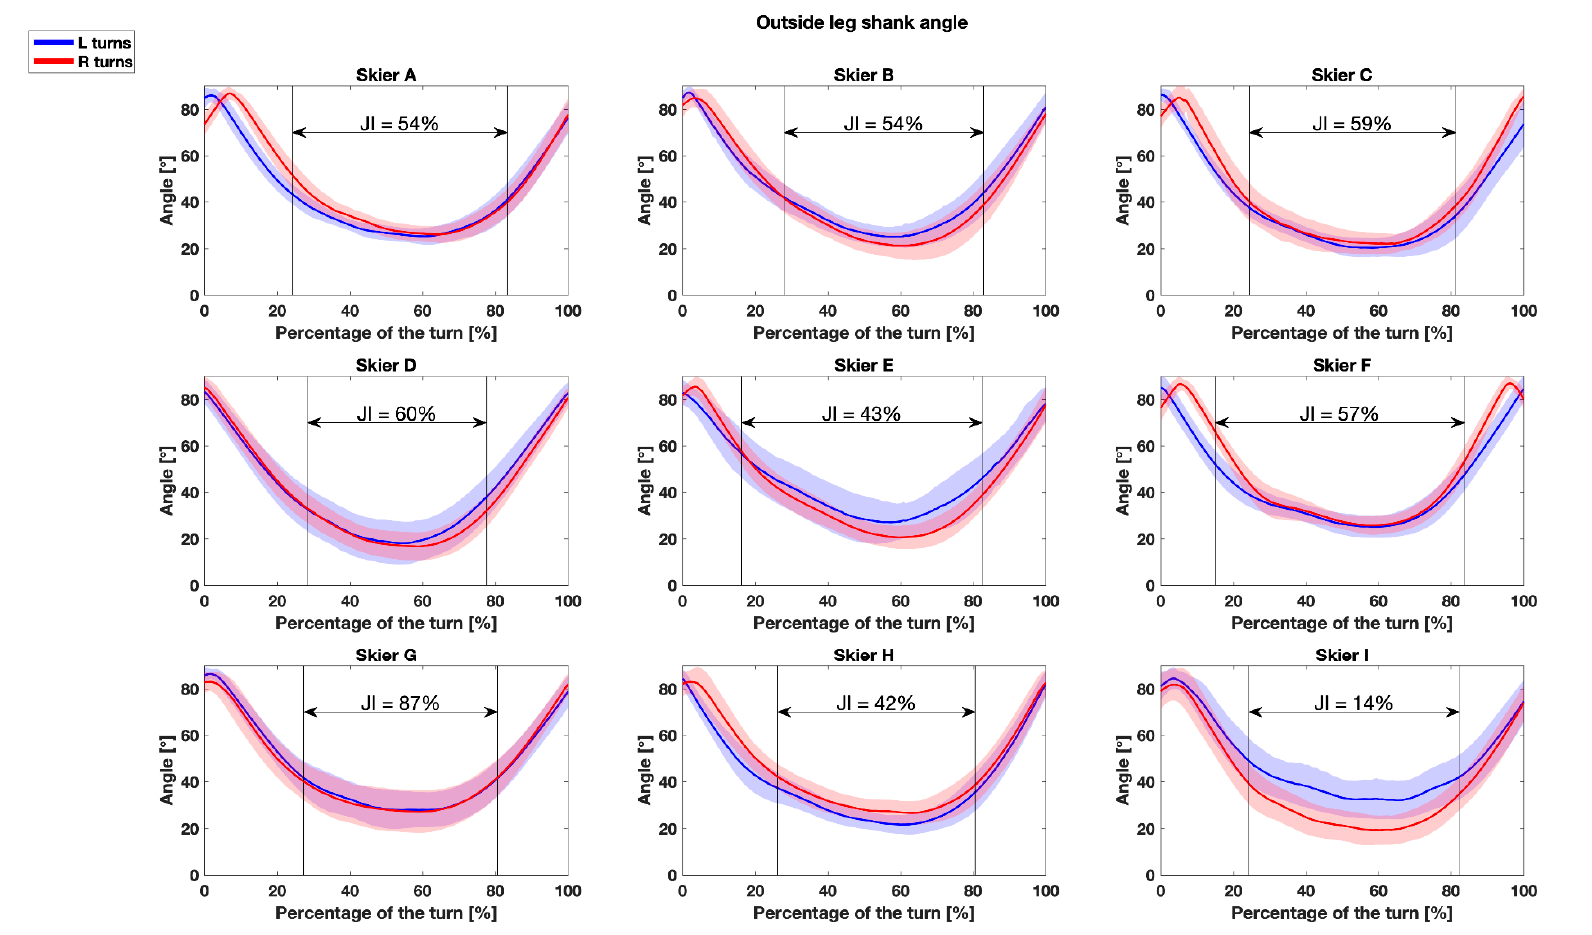
Figure 4. The angle of the outside shank of the 9 elite slalom skiers ( A – I ) during the steering phase of left and right turns, together with the corresponding Jaccard indices (JI). The two vertical lines indicate the beginning and end of the steering phase.